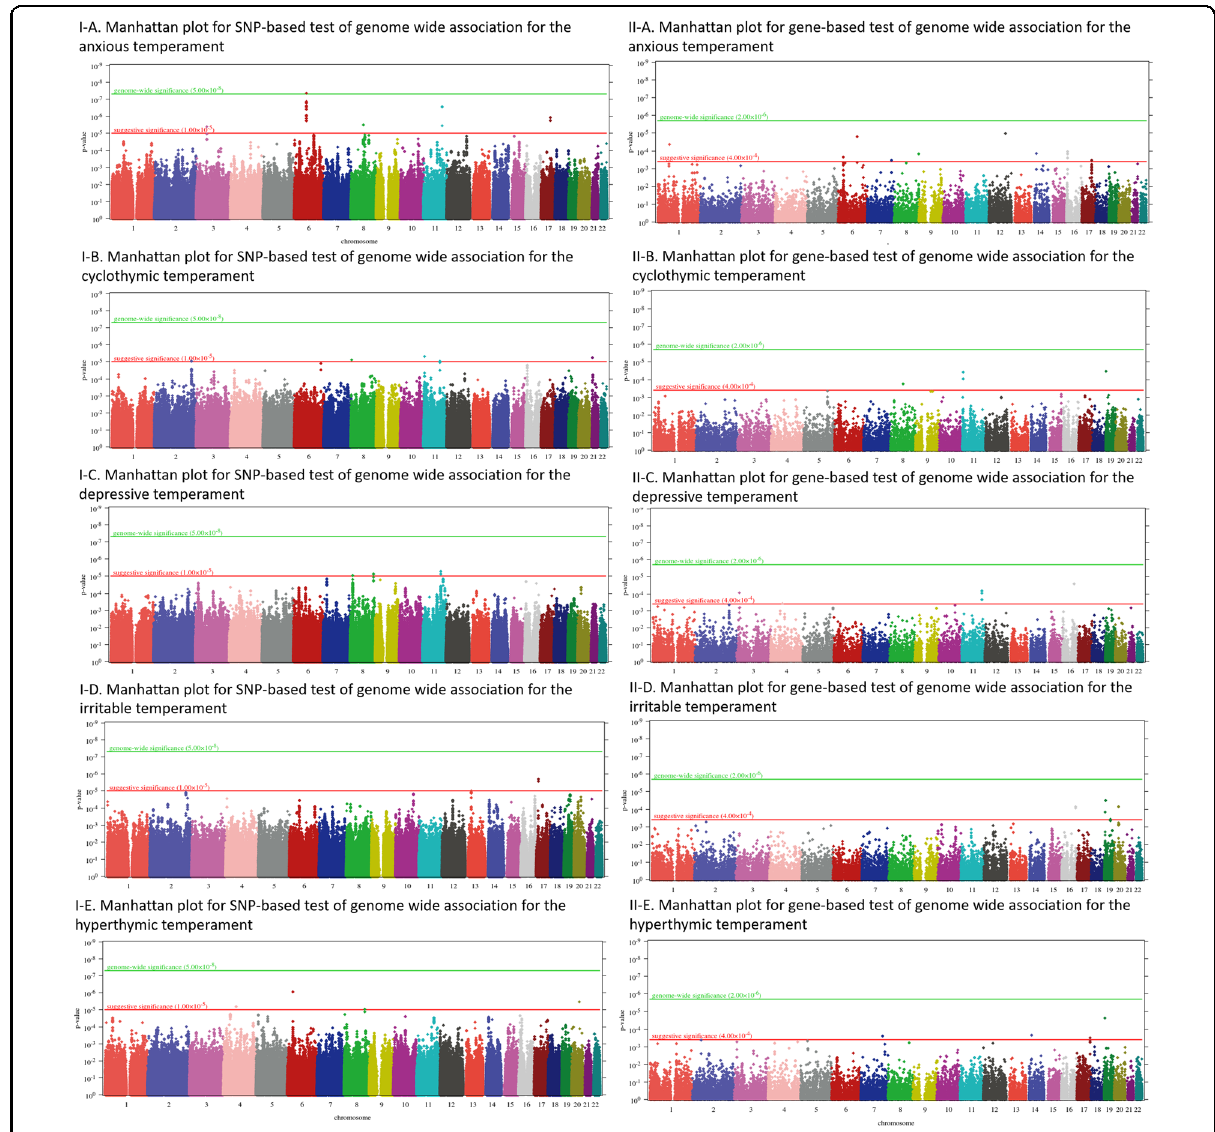
Fig. 2 Manhattan plots of genome-wide SNP-based and gene-based tests for the fi ve affective temperaments. Manhattan plots of genome- wide SNP-based tests ( I ) and gene-based tests ( II ) for anxious ( I-A , II-A ), depressive ( I-B , II-B ), cyclothymic ( I-C , II-C ), irritable ( I-D , II-D ) and hyperthymic ( I-E , II-E ) temperaments as outcome. P -value is displayed in function of genomic position for each single-nucleotide polymorphism (SNP). The red and green lines denote the levels of a suggestive and a genome-wide signi fi cance, respectively.